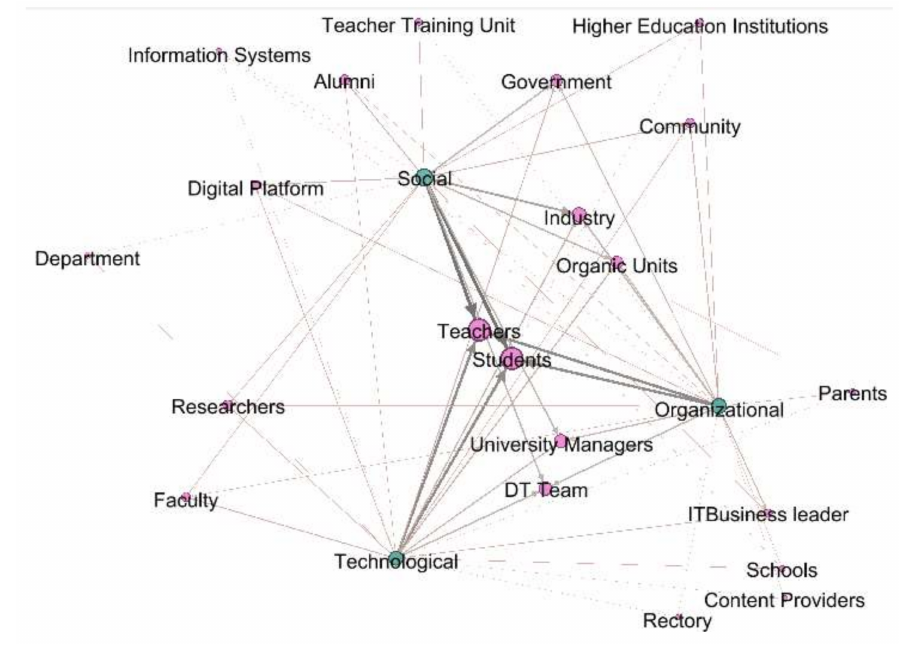
Figure 5. Actors of DT in HEIs.